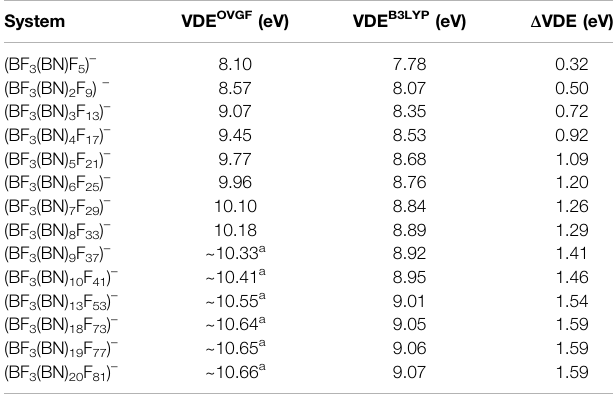
TABLE 1 | Vertical electron detachment energies (in eV) of the (BF 3 (BN) n F 4 n +1 ) – anions ( n = 1-10,13,18-20) determined at the OVGF/6-311+G(d) (labeled VDE OVGF )andB3LYP/6-311+G(d)(labeledVDE B3LYP )leveloftheory. Δ VDEstands for the difference between VDE OVGF and VDE B3LYP